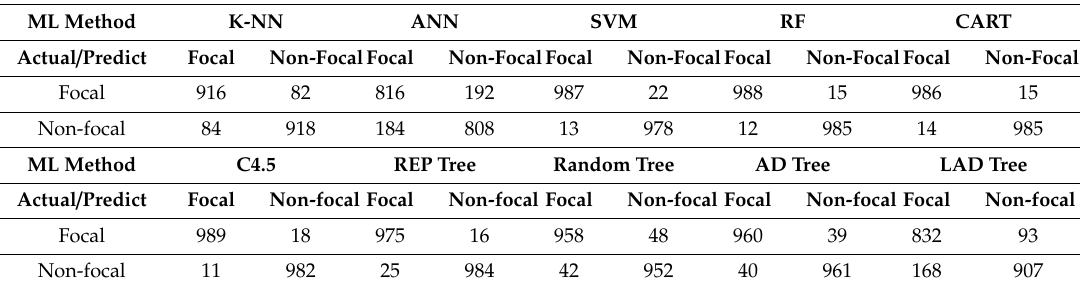
Table A3. Confusion matrix for MultiBoost.